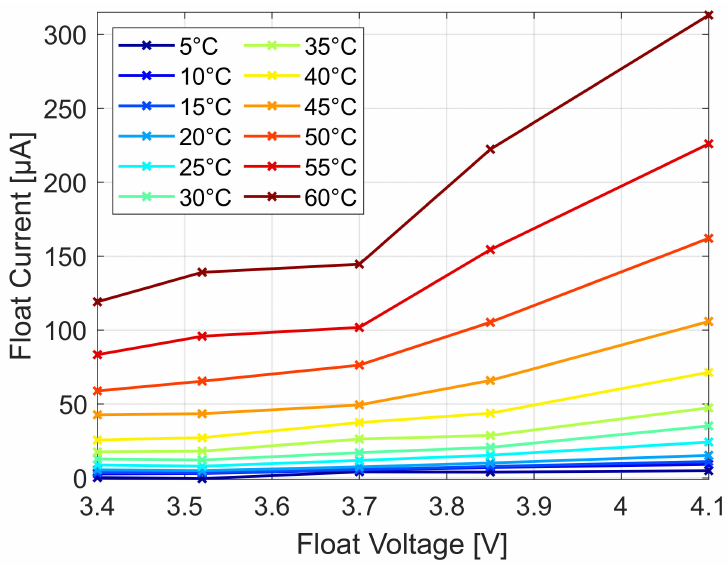
Figure 11. Float current over cell potential for several set-point temperature steps in the range of 5 to 60 ◦ C setpoint temperature.